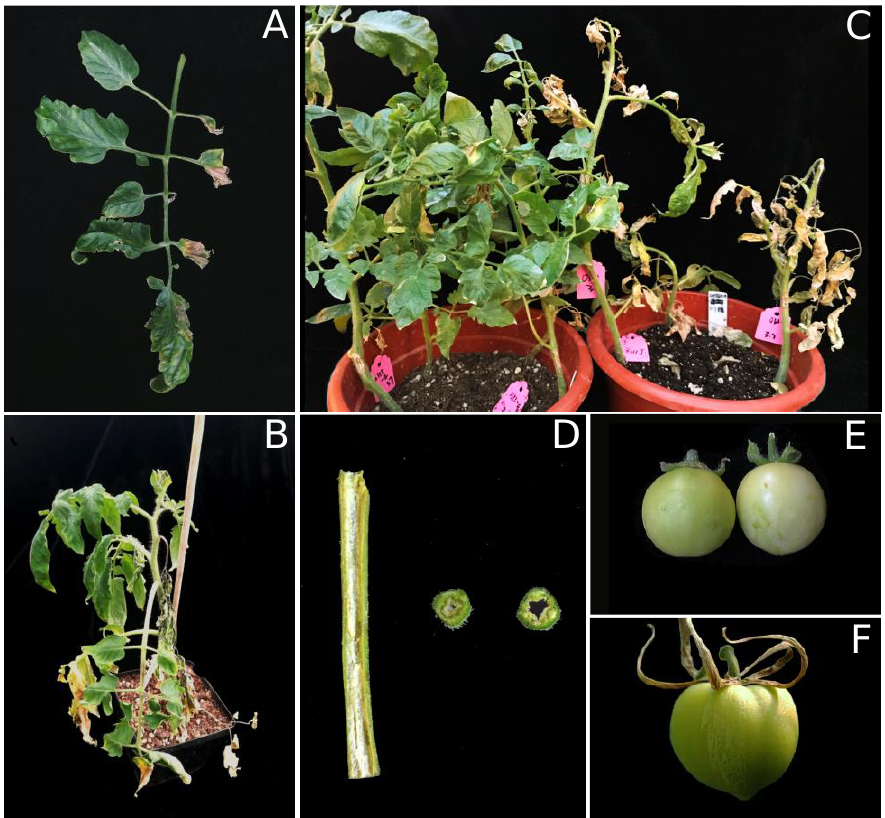
Figure 1. Symptoms of bacterial cankers on diseased tomato plants. ( A ) Unilateral wilting of a compound leaf. ( B ) Unilateral wilting of the OH88119 plant at 28 days post-inoculation (dpi). ( C ) Resistant line IBL2353 plants with mild leaf edges scorched (left), and the wilting plant of susceptible cultivar OH88119 (right) at 35 dpi. ( D ) Longitudinal section and cross-sections of OH88119 plant stems infected with bacterial cankers at 28 dpi. ( E ) Bird’s eye lesion on artificially inoculated tomato fruits. ( F ) Meshed texture on the fruit of a naturally infected tomato